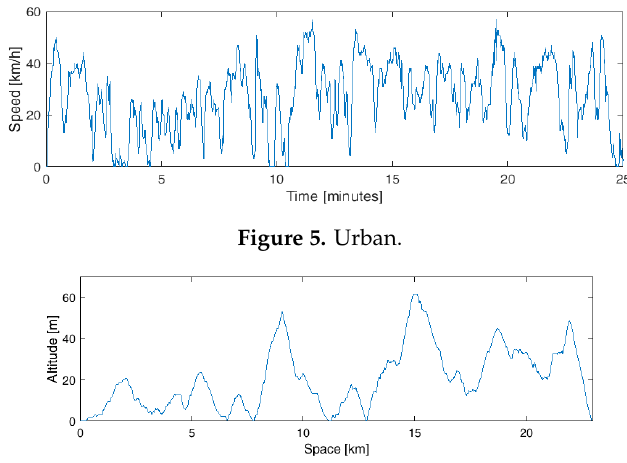
Figure 6. Fast-urban altitude profile.